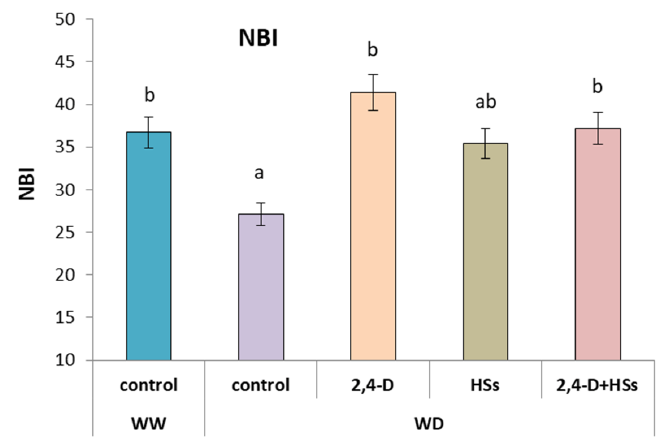
Figure 4. Nitrogen balance index (NBI) in leaves of wheat plants 7 days after treatment with Pseudomonas plecoglossicida 2,4 ‐ D (2,4 ‐ D), humic substances (HSs) and their combinations (2,4 ‐ D + HSs) under well ‐ watering (WW) and in water deficit (WD) conditions. Statistically different means are marked with different letters, p ≤ 0.05, n = 30 (ANOVA followed by Duncan’s test).